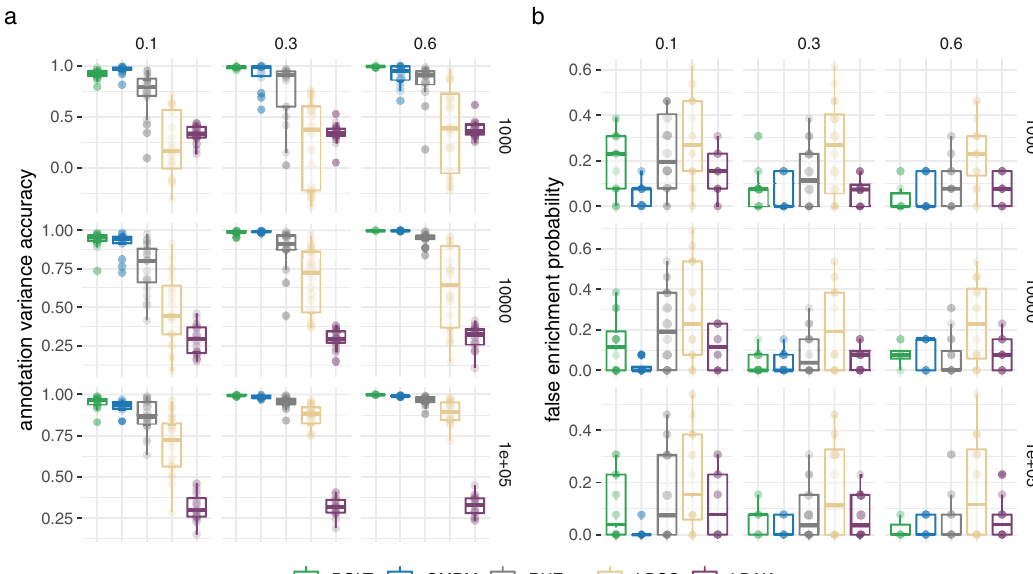
Fig. 1 Simulation study for the performance of our BayesRR-RC model implemented in the GMRM software against existing approaches for variance component and genomic annotation enrichment estimation. a Correlation of the simulated and estimated SNP heritability across 13 genomic annotation groups within each of 20 replicates for fi ve different statistical models: a mixture of regression model with multiple group-speci fi c variance components described in this work (GMRM), Haseman – Elston regression with annotation-speci fi c relationship matrices implemented in the RHEmc software (RHEmc), a multiple group-speci fi c variance component REML model implemented in the software bolt (BOLT), and two annotation summary statistic models implemented in the software LDSC and LDAK. The column facets give the simulated heritability and rows give the number of causal variants. b Probability of falsely assigning one of the 13 genomic annotation groups as explaining 2 times greater proportion of variance given the proportion of SNPs mapping to the annotation. The column facets give the simulated heritability and rows give the number of causal variants. Boxplots give the median with 25th and 75th percentile and 95% credible intervals for n = 20 simulation replicates in both